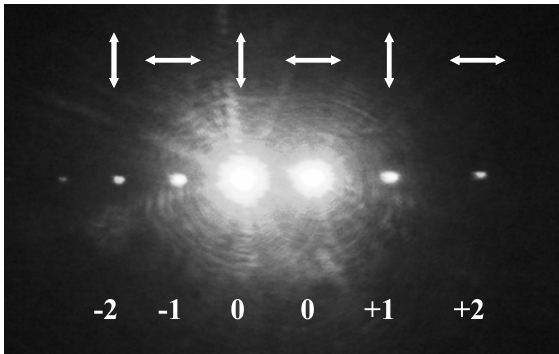
Fig. 9 Self-diffraction of light observed in the case of polarization s − p grating recording in photochromic polymers. Arrows show planes of light polarization observed in the far-field for various diffraction